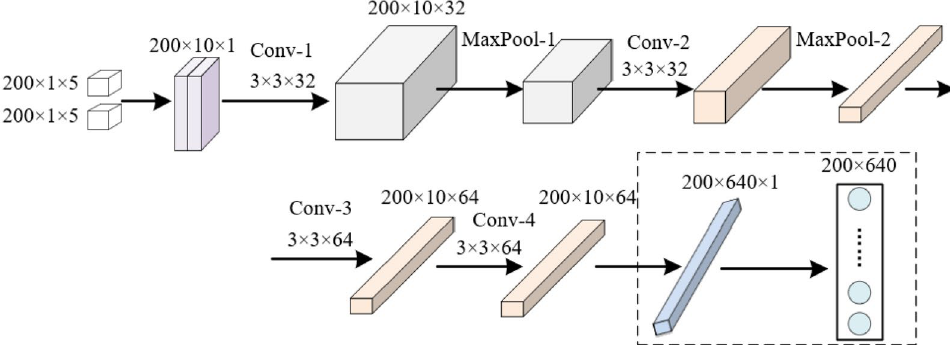
Figure 5. CNN-based spatial correlation features extraction